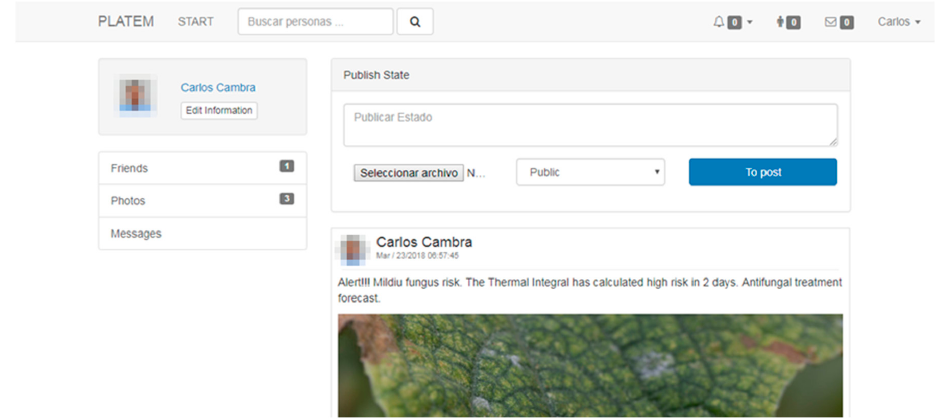
Figure 16. Auto post, rule triggered.